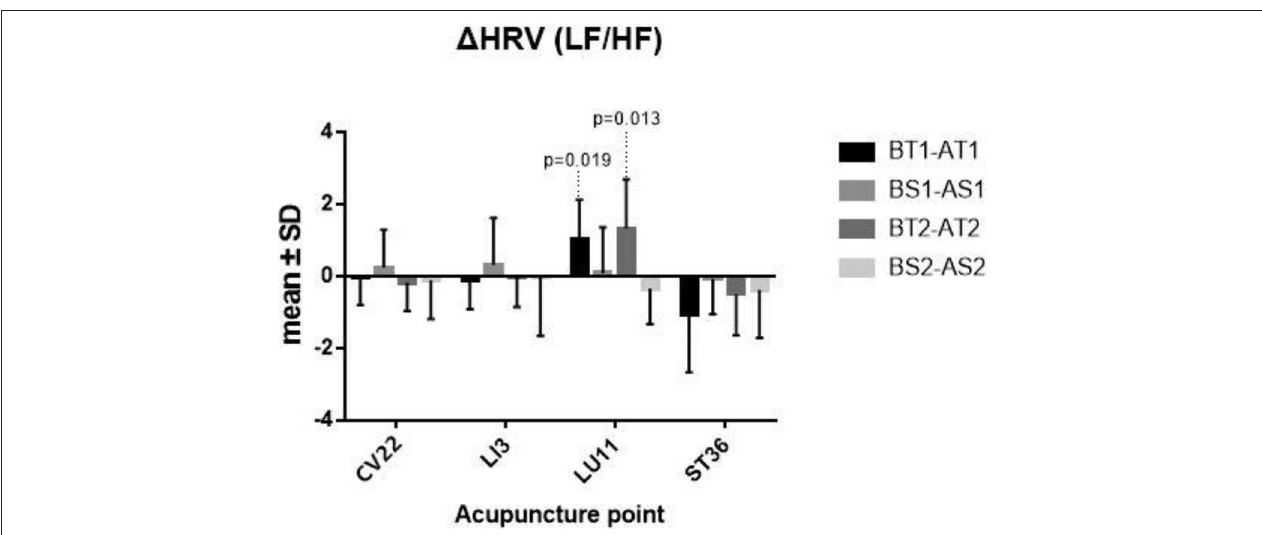
FIGURE 5 | 1 HRV. BT1 means before TEA in sequence 1; AS2 means after sham-TEA in sequence 2. 1 = baseline—after TEA/sham-TEA.